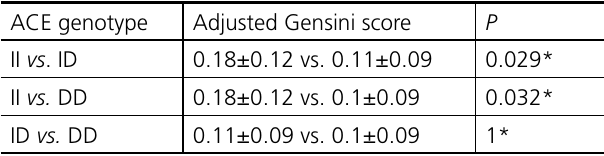
Table 4. Comparison of angiographic severity of coronary ar- tery disease in different ACE